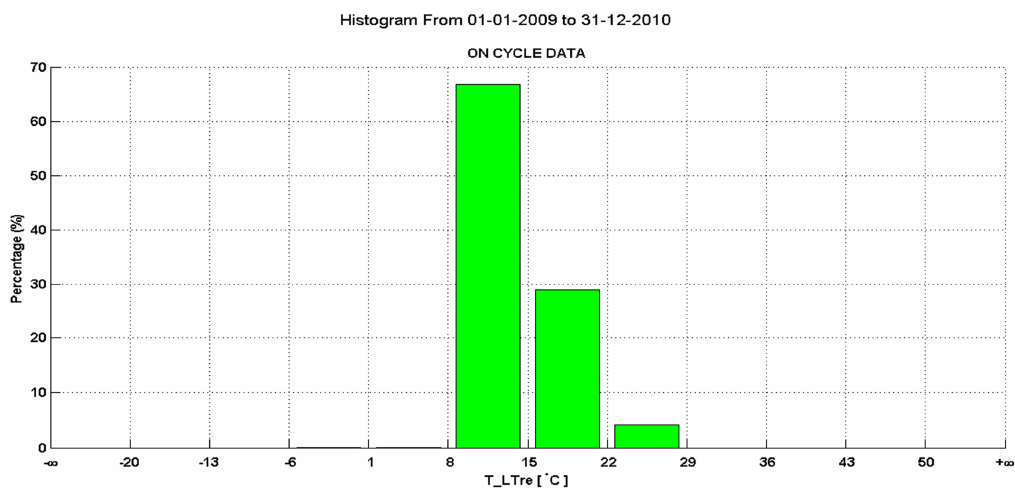
Figure 11. Histogram of the return temperature in the low temperature cycle showing only the temperatures while the system is on, showing no outliers (violation bins on the left and right are empty).